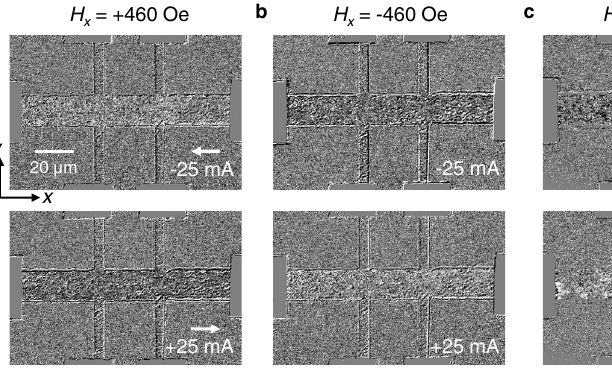
Fig. 4 | MOKE images showing current-induced switching in Mn 3 Sn. a , b The imagesofTa(2)/MgO(2)/Mn 3 Sn(12)afterapplicationofalongitudinalcurrentpulse with an amplitude of − 25mA (upper panel) and 25mA (lower panel) in an long- itudinal fi eld H x of +460Oe and − 460Oe, respectively. c , d The MOKE images of